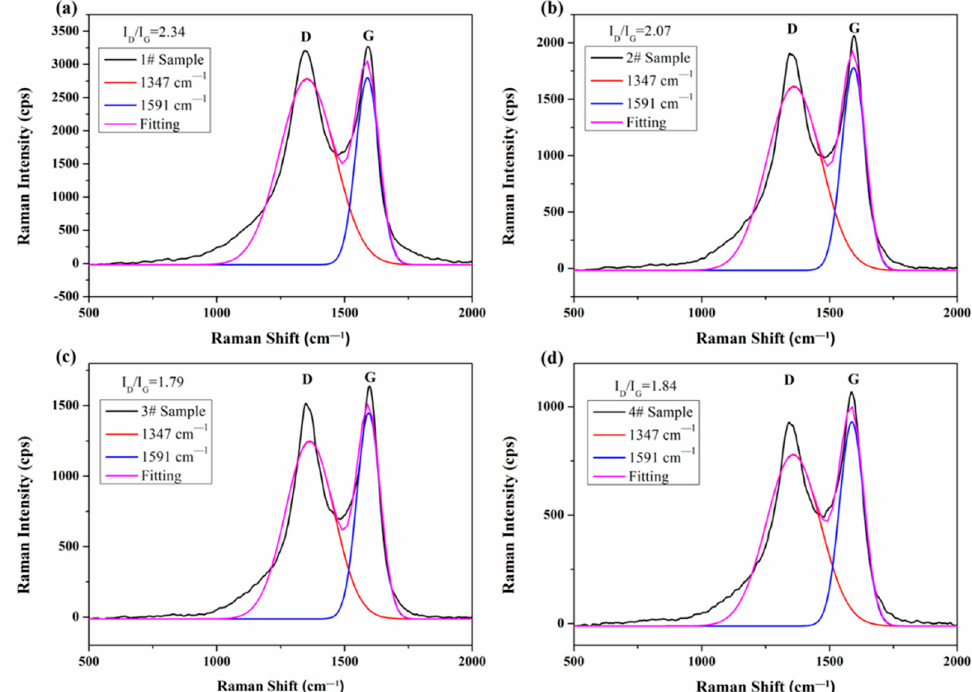
Figure 7. Raman spectra of each carbonaceous deposit layer in the coking chamber: ( a ) #1 carbonaceous deposit layer; ( b ) #2 carbonaceous deposit layer; ( c ) #3 carbonaceous deposit layer; and ( d ) #4 carbonaceous deposit layer.